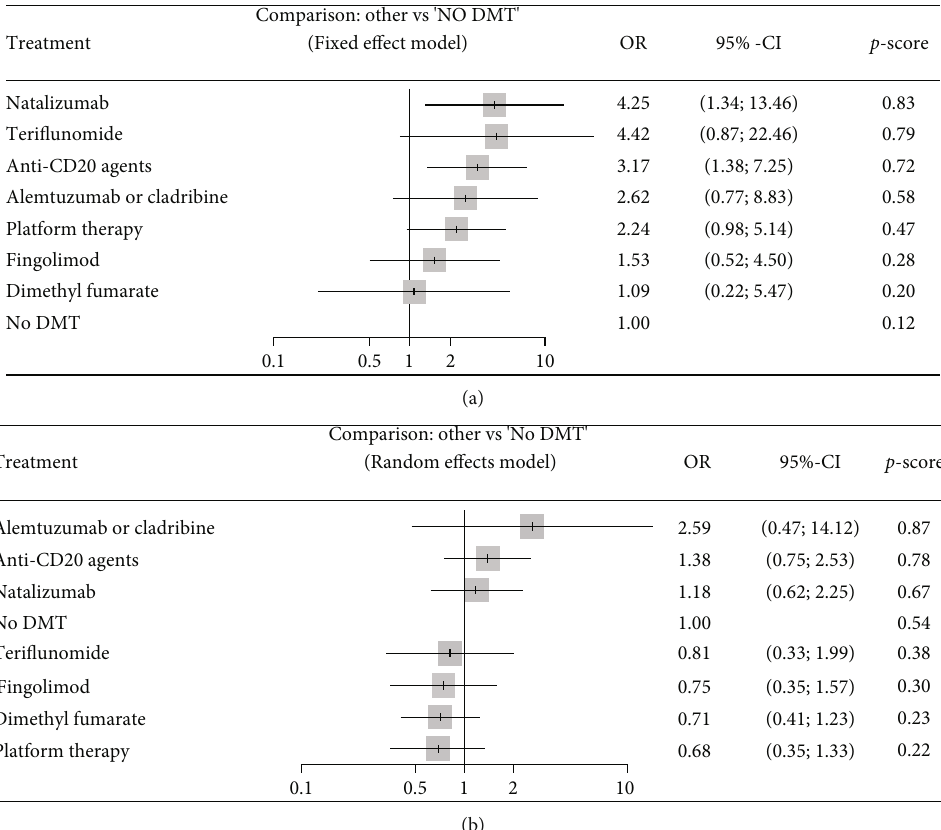
Figure 3: Forest plots of comparisons between DMTs and no DMTs for risk of acquiring COVID-19. Platform therapy: interferon and glatiramer acetate; anti-CD20 agents: rituximab and ocrelizumab. (a) Results of univariate analyses. (b) Results of multivariate analyses. P score ranges from zero to 1. A higher P score indicates a greater risk of being infected with